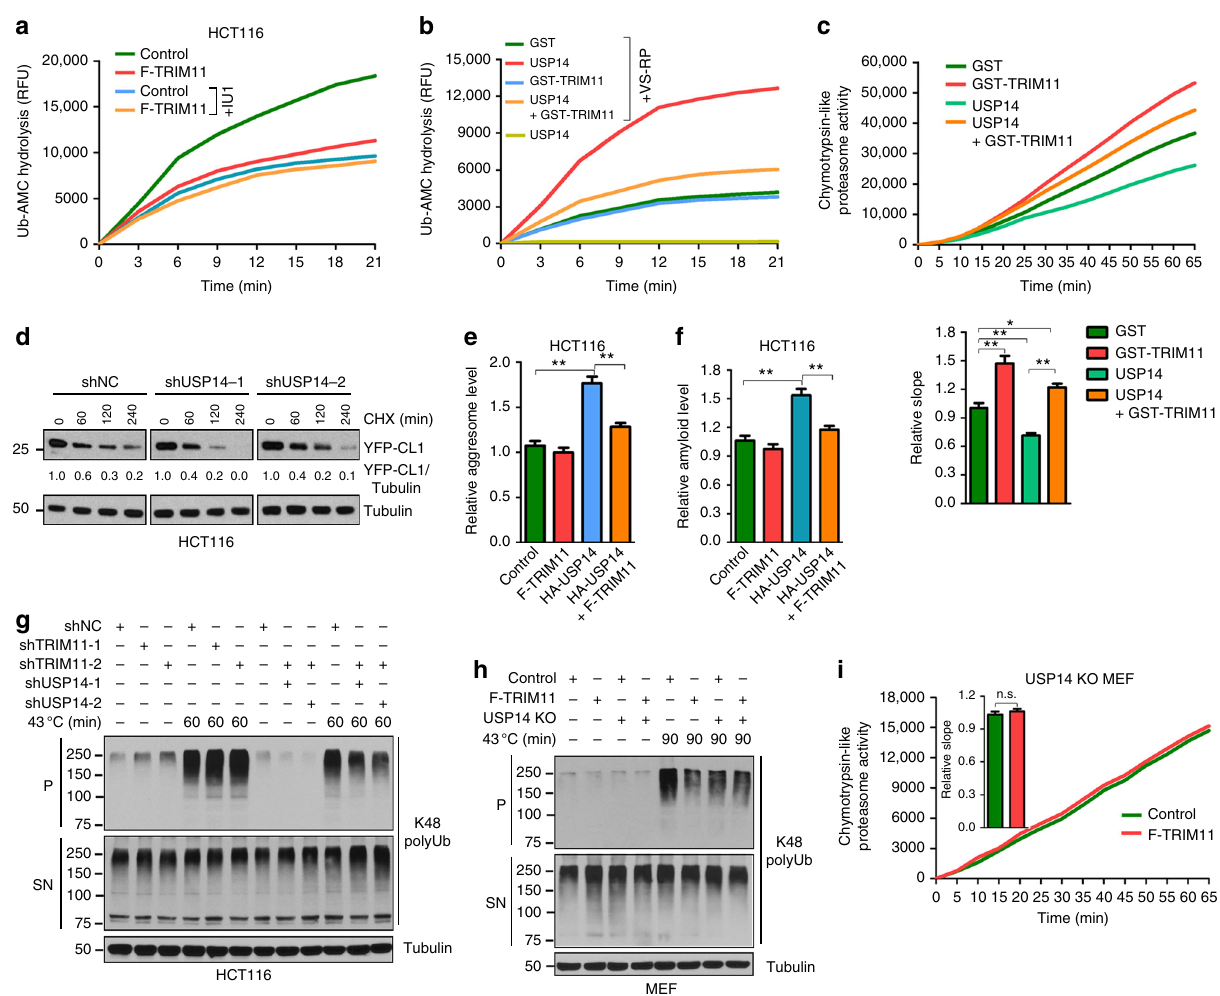
Fig. 5 TRIM11 counteracts the effects of USP14 on proteasome activity and degradation of misfolded proteins. a Deubiquitinase activity in proteasome- enriched lysates from control and TRIM11-overexpressing HCT116 cells treated with vehicle (DMSO) or IU1 (100 μ M). b RP pre-treated with Ub-VS (VS-RP, 5 nM) was incubated with recombinant GST, Flag-USP14, GST-TRIM11, or Flag-USP14 plus GST-TRIM11 proteins (50 nM each). Deubiquitinase activity was measured using Ub-AMC. c Chymotrypsin-like proteasome activity in HCT116 cell lysates incubated with the indicated recombinant proteins (50 nM each), was measured using Suc-LLVY-AM. Slopes relative to that of control are also shown, n = 7. d Turnover of YFP-CL1 in control and USP14-depleted HCT116 cells. The relative YFP-CL1/tubulin ratios were quantitated from three independent experiments. The exposures of the corresponding control and USP14-knockdown blots were adjusted to achieve comparable levels of YFP-CL1 at time 0. e , f Relative abundance of aggresome ( e ) and amyloid ( f ) in HCT116 cells expressing the indicated proteins. g K48 polyUb conjugates in HCT116 cells expressing the indicated shRNAs, and treated with and without heat shock. h Levels of K48 polyUb conjugates in wild-type and Usp14 KO MEFs infected with control or TRIM11 lentiviruses, and grown under normal or heat stress conditions. i Chymotrypsin-like proteasome activity in control and TRIM11-overexpressing Usp14 KO MEF cells, as measured by fl uorometric substrate Suc-LLVY-AMC. Slopes relative to that of control are shown, n = 7. In a – c , e , f , and i , data represent the mean ± SEM ( n = 3 unless otherwise indicated). * P < 0.05; ** P < 0.01. Uncropped blots are presented in Supplementary Fig. 12. n.s.: not signi fi